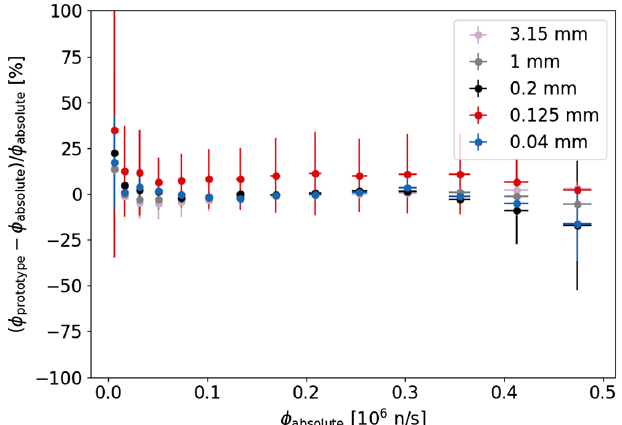
FIG. 11. Absolutely calibrated counts from V17. The x-axis shows the ϕ , the absolute beam intensity measured and absolute corrected by the absolutely calibrated 3053 LND fission chamber. The y axis shows the measured values corrected by the results of simulations for each